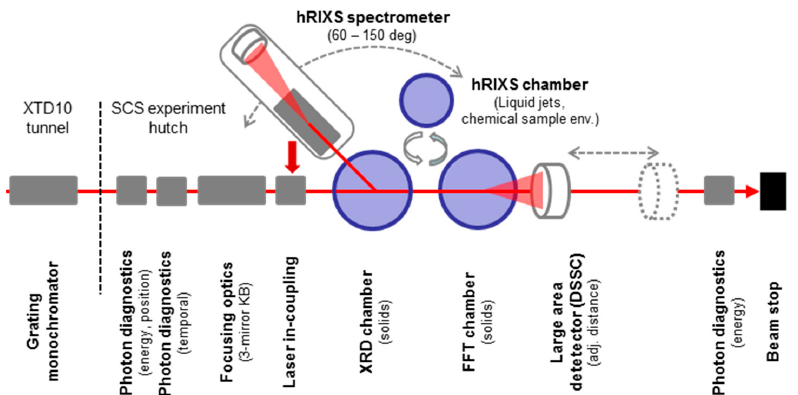
Figure 7. Schematic outline of the SCS scientific instrument at the SASE3 FEL. Shown are major instrumentation items installed in the photon beam transport tunnel and experiment hutch comprising the beam transport, focusing and diagnostic devices as well as the Heisenberg RIXS spectrometer contributed by the hRIXS user consortium.